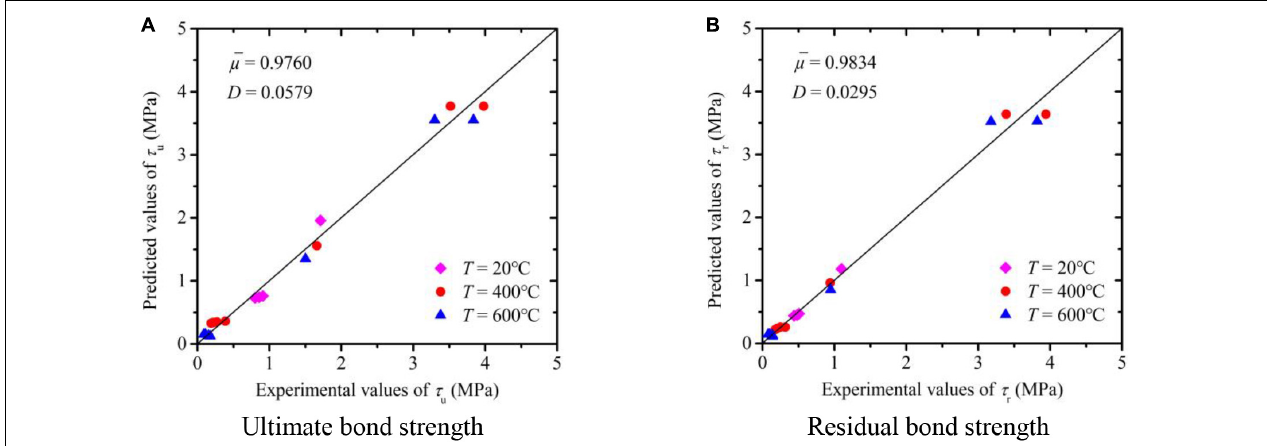
FIGURE 11 | Comparison of experimental and predicted τ u and τ r . (A) Ultimate bond strength. (B) Residual bond